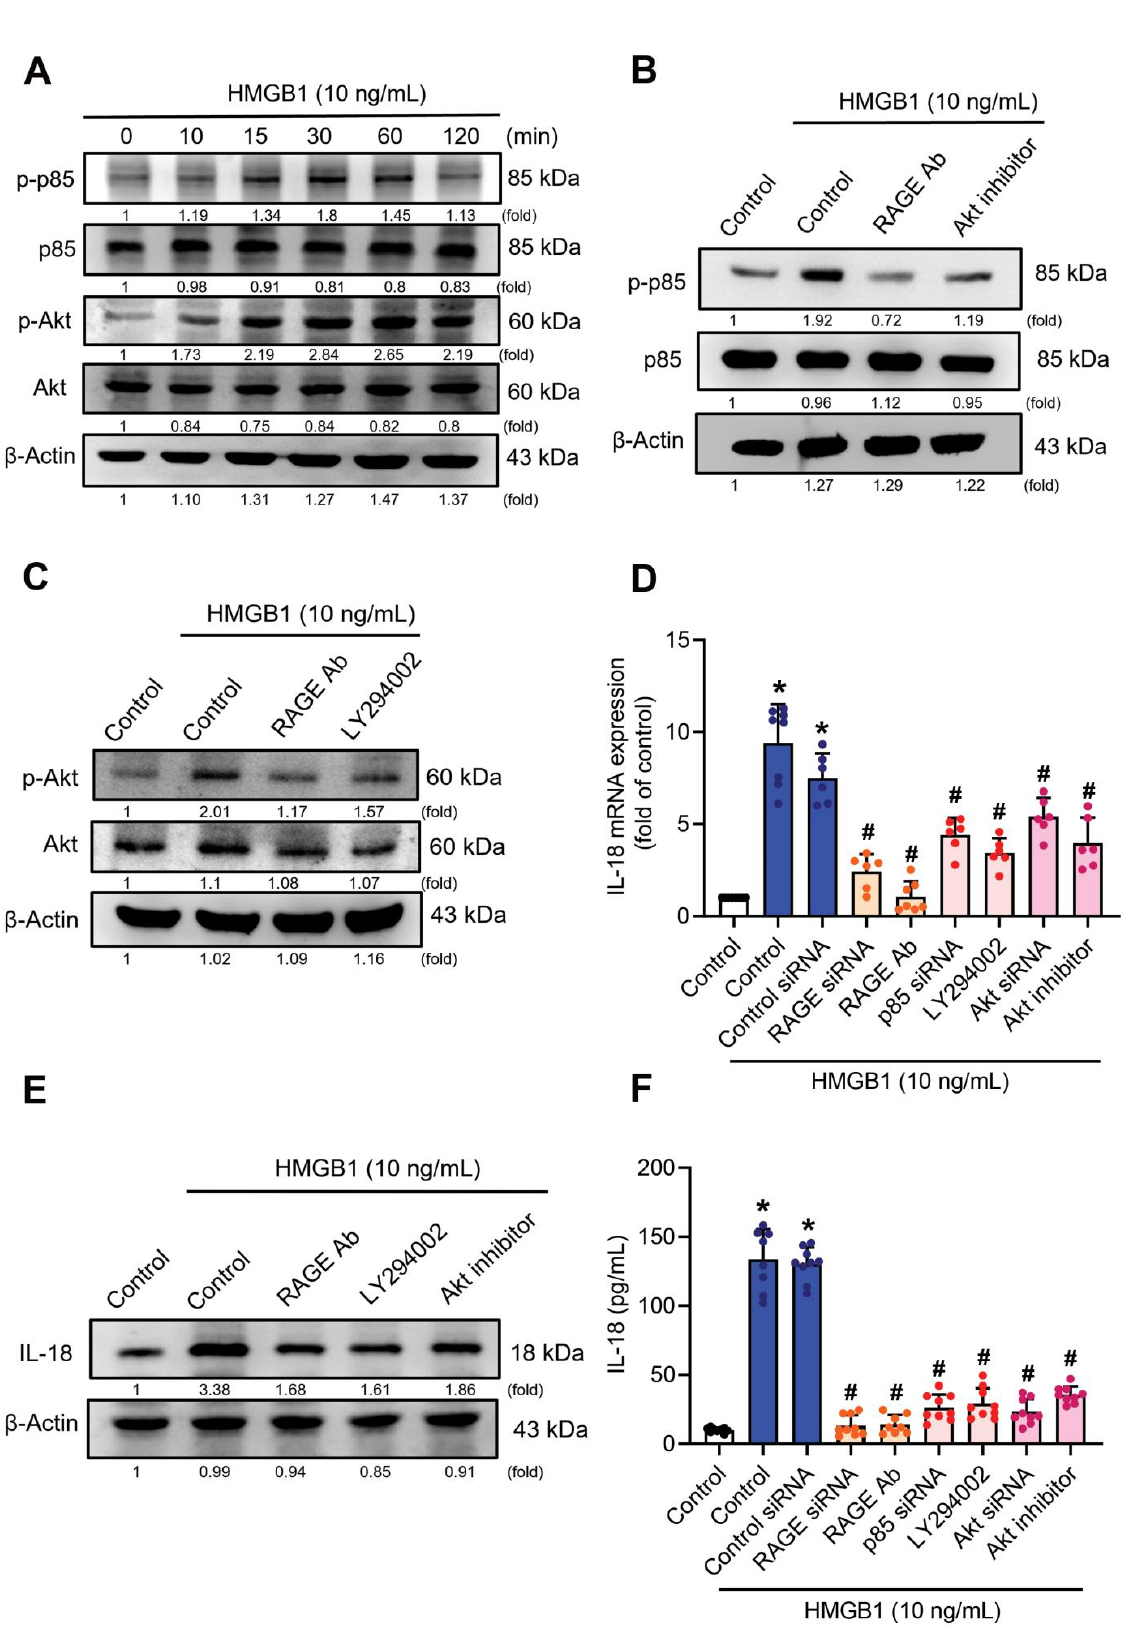
Figure 3. The RAGE/p85/Akt signaling pathway is involved in HMGB1-induced upregulation of IL-18 expression. ( A ) C2C12 cells were treated with 10 ng/mL of HMGB1. Cell lysate was